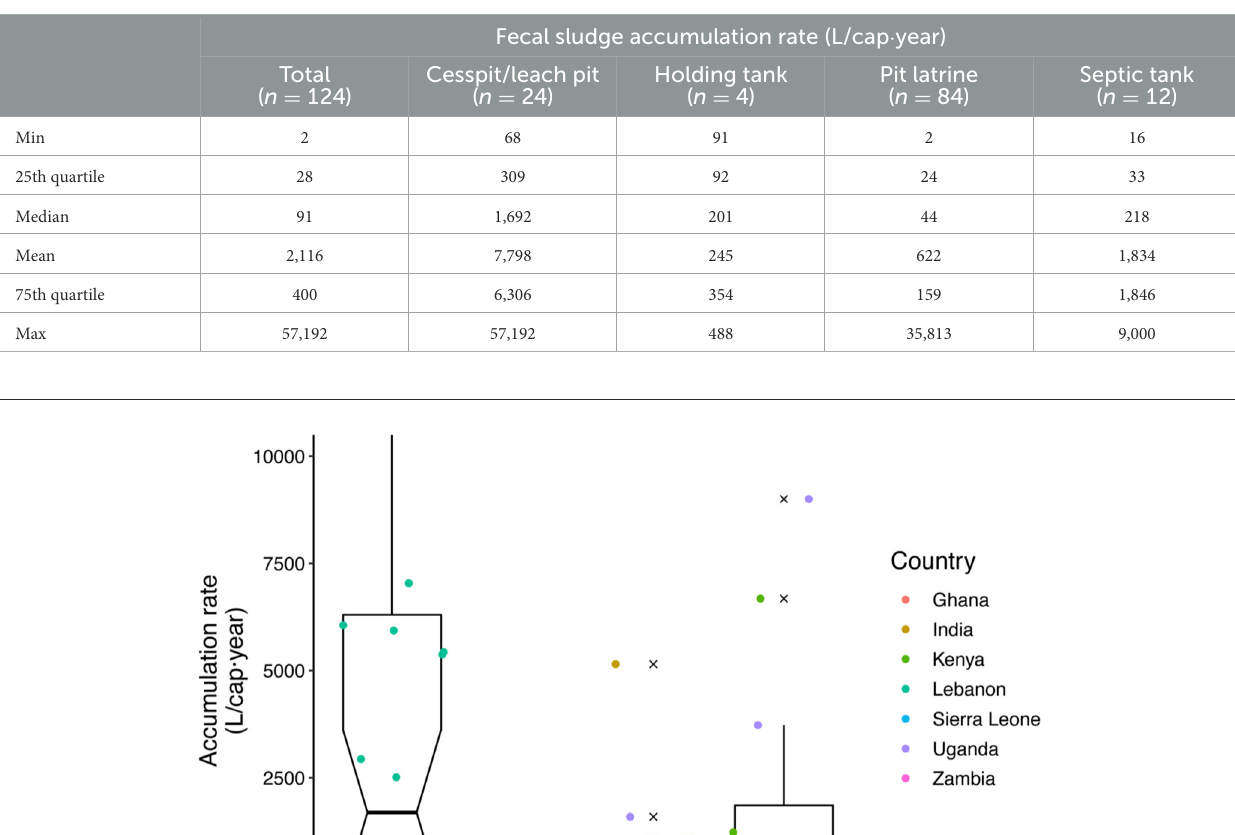
TABLE 3 Descriptive statistics of fecal sludge accumulation rate, for all data combined, and per containment type.